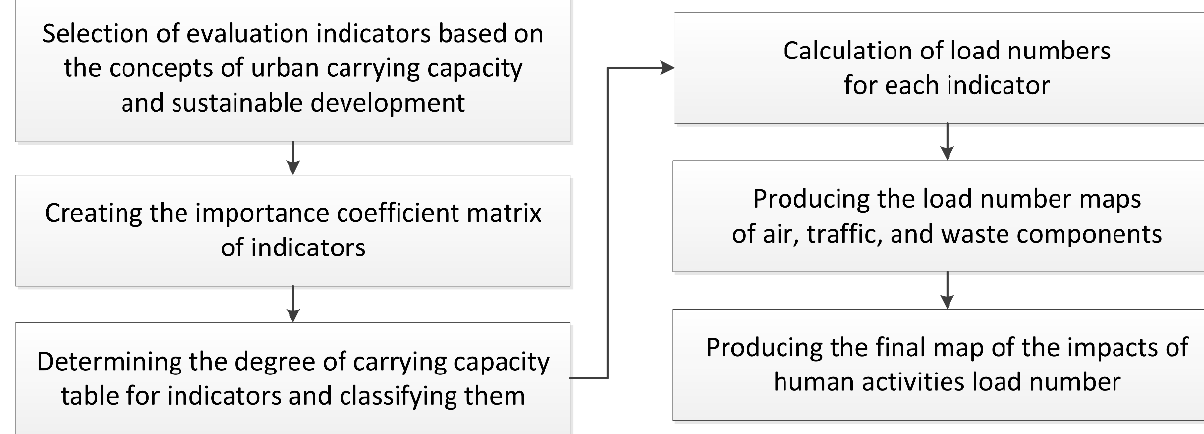
Figure 2. The research method fl owchart.